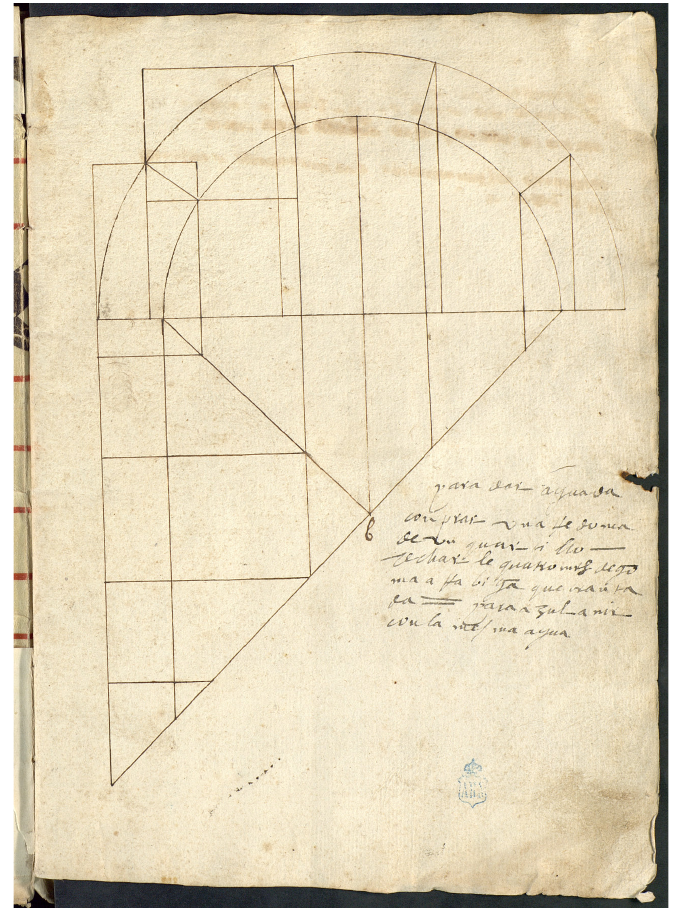
Figure 2. “Stonemasonry pattern” included in the notebook from the monastery of San Benito el Real in Valladolid [Archivo Histórico Nacional (A.H.N.), Clero, MPD, 109, f. 1 r]. © Archivo Histórico Nacional.